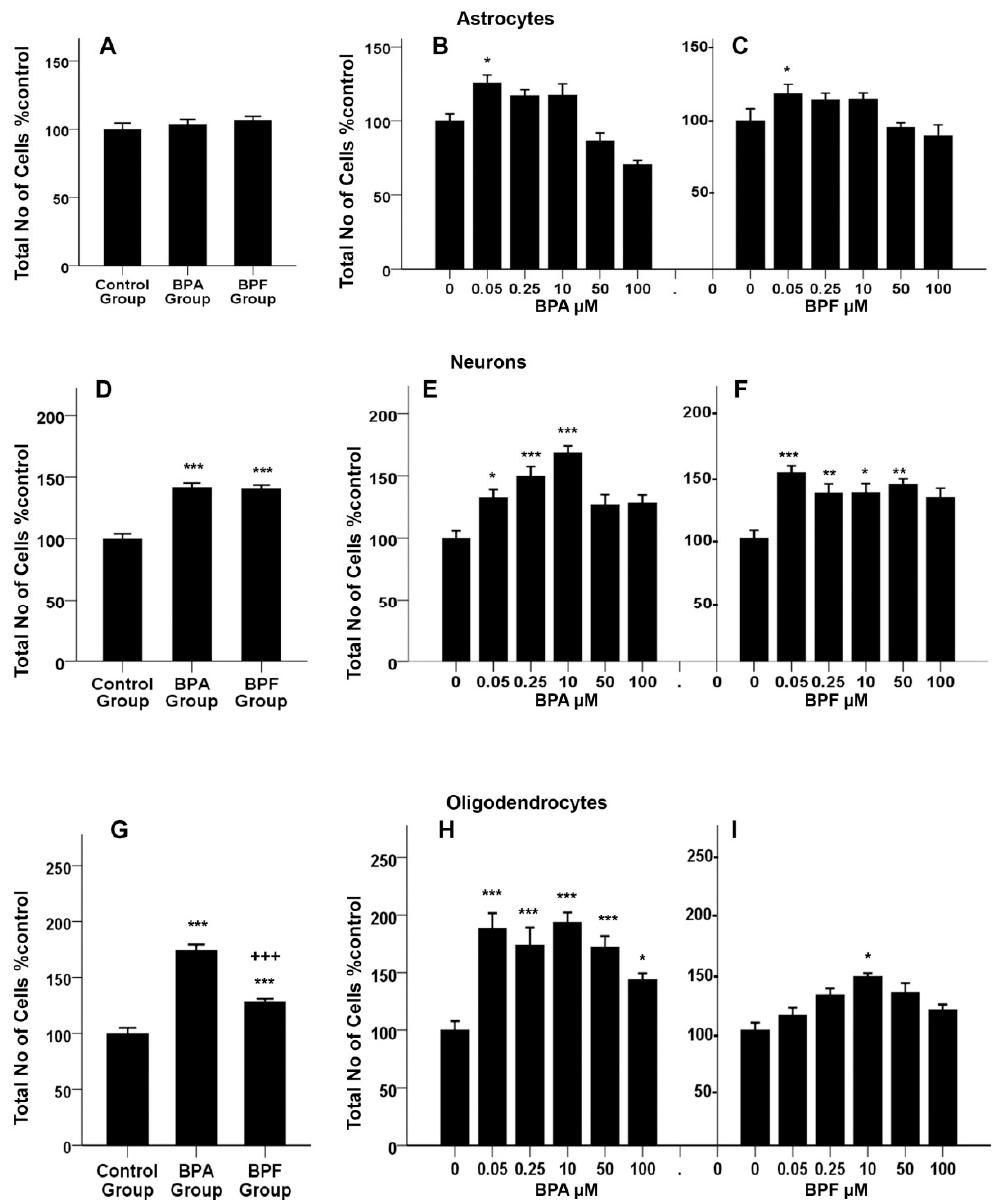
Figure 7. Effects of different concentrations of Bisphenol A (BPA) or Bisphenol F (BPF) treatment for seven days on cell proliferation of differentiating rNSCs into astrocytes, neurons, and oligodendrocytes. The “total number of cells % control” was enumerated as an index of cell proliferation in, ( B , C ) astrocytes, ( E , F ) neurons, and ( H , I ) oligodendrocytes, respectively. Group-wise comparisons of BPA and BPF for astrocytes ( A ), neurons ( D ), and oligodendrocytes ( G ) are illustrated. Differentiated astrocytes, neurons, and oligodendrocytes were stained with specific protein-markers GFAP, MAP2-clone-AP18, and mGalc, respectively. DAPI stained nuclei of fluorescent and phase-contrast superimposed images were enumerated as “the total number of cells %control” of each cell category. “Total No of Cells %control” = (No of total nuclei of treated cells ÷No of total nuclei of control cells) × 100. Each data point represent mean ± SE; * p < 0.05, ** p < 0.01, ***, +++ p < 0.001 compared with the relevant control groups.